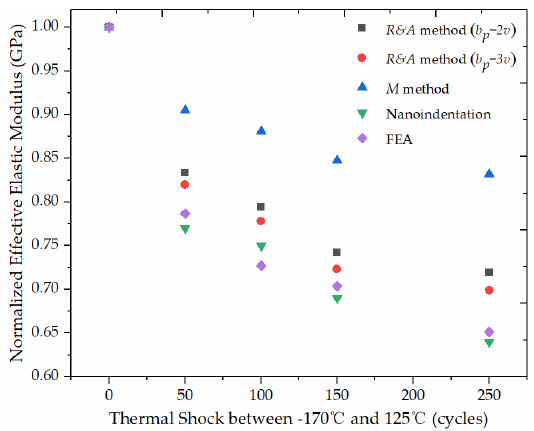
Figure 14. Relative comparison of FEA, analytical models and nanoindentation results.